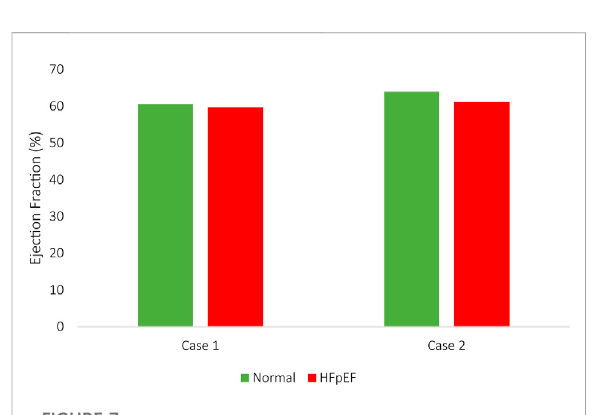
FIGURE 7 The ejection fraction of normal and HFpEF con fi